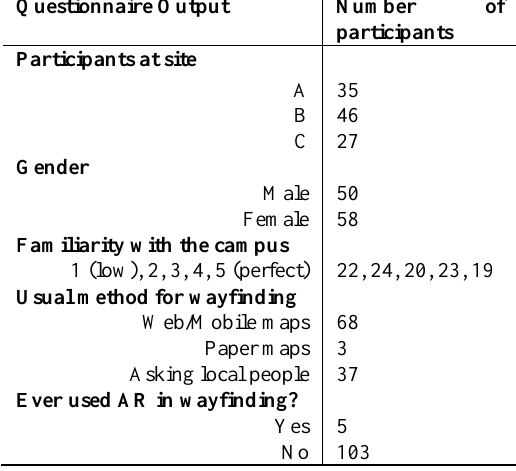
Table 2. Overall results of the first task